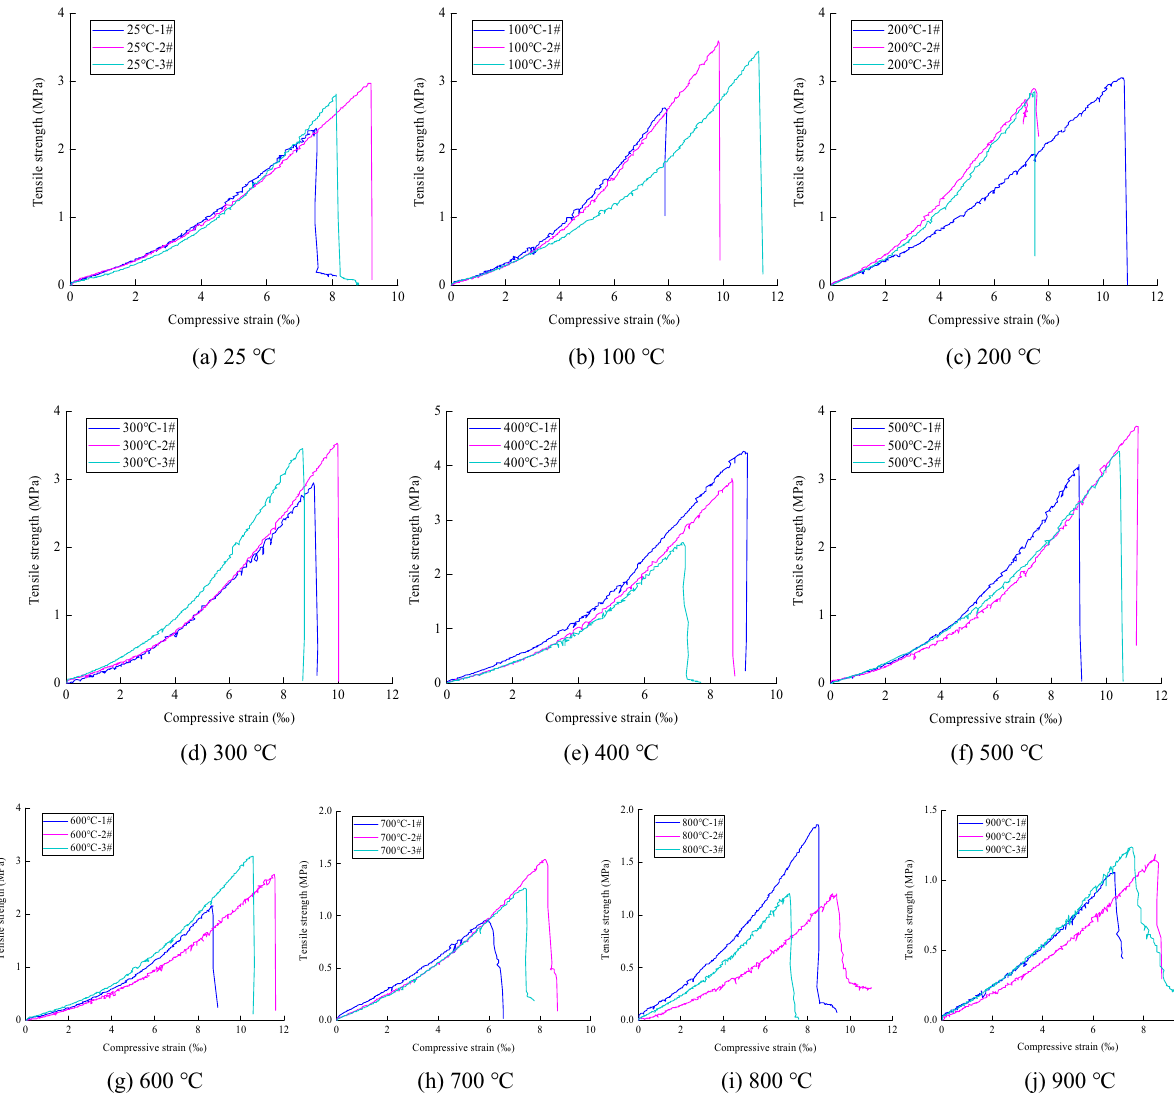
Figure 7. The tensile stress–compressive strain curves of the coarse sandstone samples treated at different